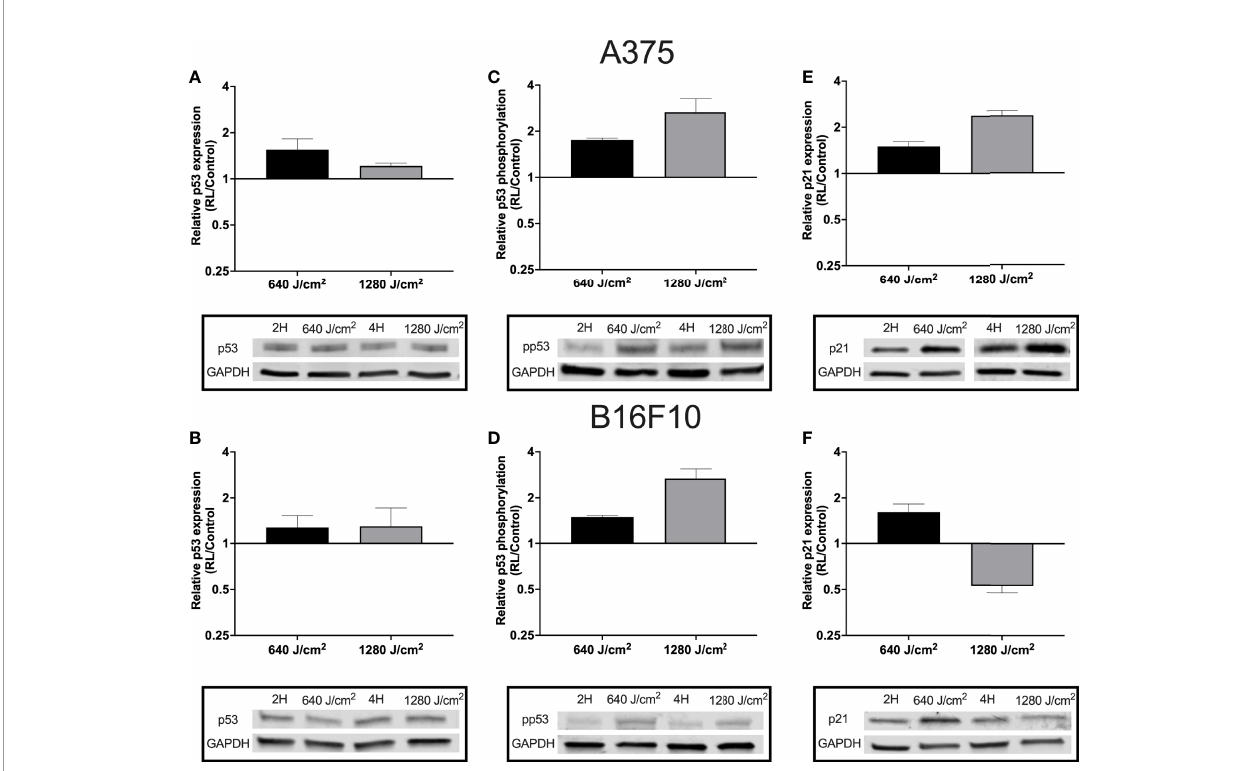
FIGURE 3 | RL increases p53 expression and phosphorylation. Protein was collected from A375 and B16F10 cells at 24 hours following irradiations with 640 and 1280 J/cm2. Relative expression of p53 in (A) A375 and (B) B16F10. Isolated protein from A375 cells treated with 640 and 1280 J/cm2 RL or control was probed with p53 antibodies twice (n=2) and six times (n=6), respectively. Isolated protein from B16F10 cells treated with 640 and 1280 J/cm2 RL or control was probed with p53 antibodies three times (n=3) and twice (n= 2 ). (C) p53 phosphorylation was measured in A375 and (D) B16F10 cells. In A375 cells, 640 and 1280 J/cm 2 treated samples were run fi ve-times (n=5) and three times (n=3), respectively. In B16F10 cells, 640 and 1280 J/cm 2 treated samples were analyzed with phosphorylated p53 antibodies twice (n=2) and fi ve times (n=5). (E) p21 expression in A375 and (F) B16F10 cells following irradiation with 640 and 1280 J/cm 2 RL. In A375 cells, 640 and 1280 J/cm 2 treated samples were run fi ve-times (n=5) and twice (n=2). In B16F10 cells, 640 and 1280 J/cm 2 treated samples were run three-times (n=3) and twice (n=2). 2H, 2 hour control; 4H, 4 hour control; 640, 640 J/cm 2 ; 1280, 1280 J/cm 2 ; ns, not signi fi cant; and RL, Red